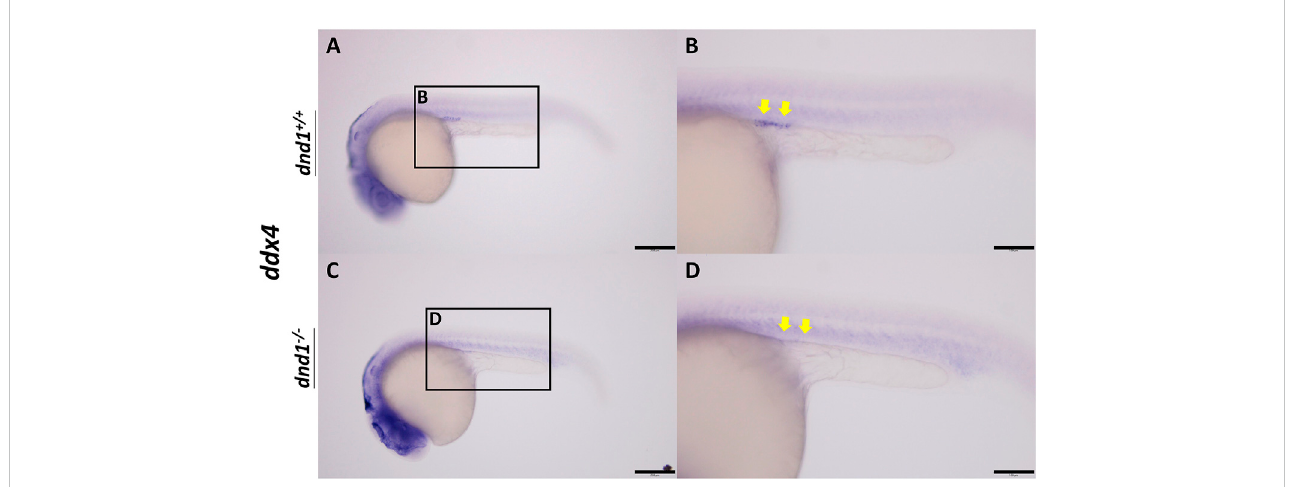
fi sh 2 generation. (A) - (B) Wild-type zebra